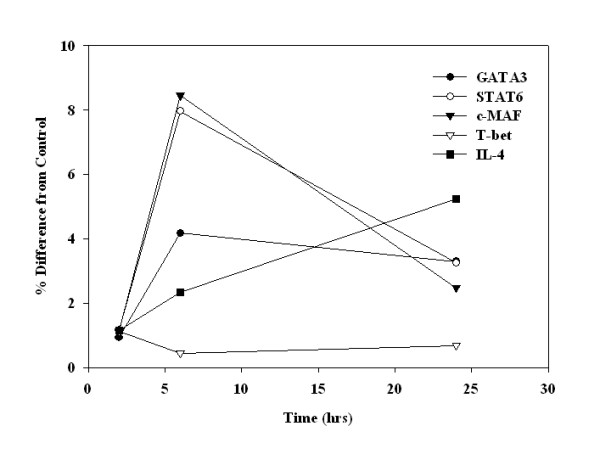
ATRA upregulates the expression of Th2 transcription factors within anti-CD3 mAb-stimulated T cells. Taqman® semi-quantitative PCR for the Th2 transcription factors, GATA-3, STAT6 and c-MAF, and the Th1 transcription factor, T-bet, were examined using total cellular RNA derived from 2, 6 and 24 hour stimulated anti-CD3 mAb-stimulated T cells (2.5 × 106/ml) treated with ETOH or ATRA (10-7 M). In addition, IL-4 and GAPDH assessments were also performed. Values obtained for each cytokine message was normalized to that obtained for GAPDH in the same sample as described in the Methods. The normalized values were then expressed as a function of the ETOH control sample. The data shown is representative of two donors examined.